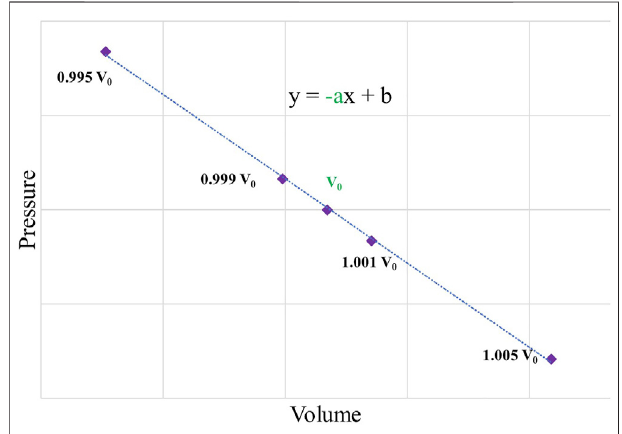
FIGURE 2 | A pressure – volume diagram with the isotropic compression and expansion by − 0.5, − 0.1, 0.1, and 0.5% of the volume.